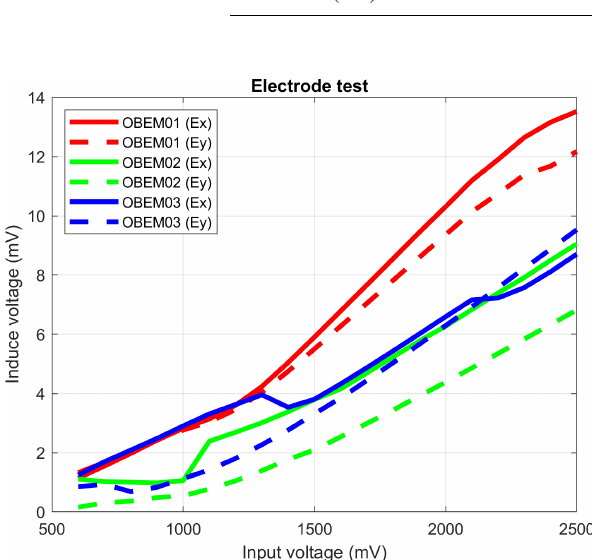
Figure 9. The responses of the electrodes with varying voltages. The input ranged from 500 to 2500mVDC to check the induced voltage; the induced voltages are proportional to the input